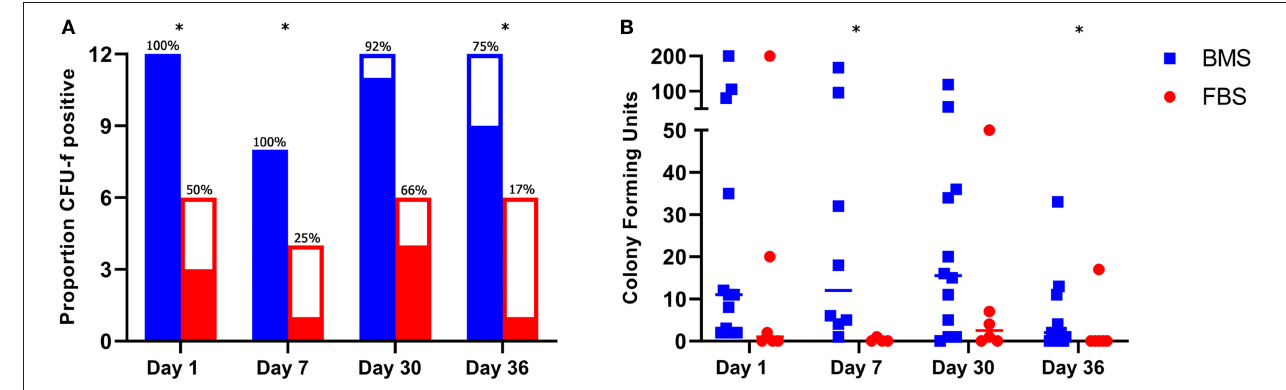
FIGURE 7 | Increased synovial MSC isolation after BMS-MSC administration compared to FBS-MSC administration. (A) The proportion of synovial fluid CFU-f plates with at least one colony (filled section of the bar) was higher in BMS-MSC recipients [significance denoted by asterisks, * p ≤ 0.05]. Bars represent total number of CFU-f cultures performed per day with solid portions denoting when CFU-f colonies were present and clear portion denoting a lack of CFU-f colonies. (B) The synovial MSC concentration was higher in BMS-MSC recipients 1 week after each